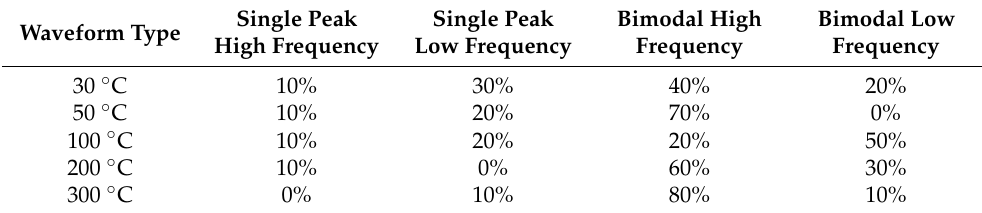
Table 2. Power spectrum probability table for different temperature